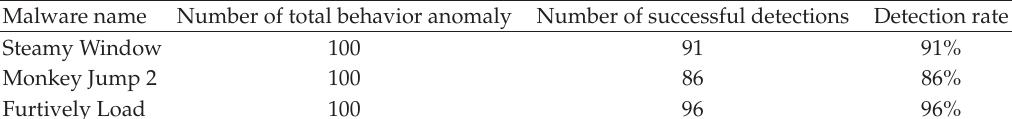
Table 1: Comparison of virus detection rates.